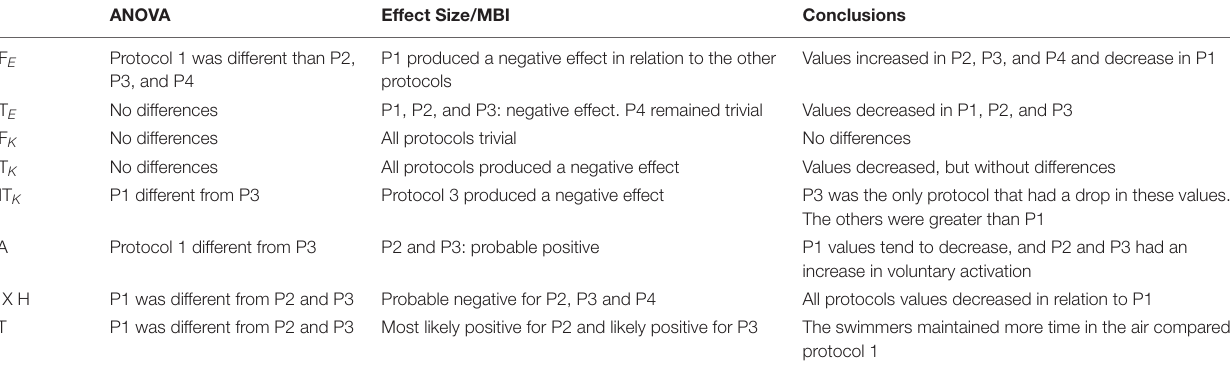
TABLE 1 | Comparison of statistical methods (ANOVA, Effect Size and Magnitude Based Inferences) used for analysis and conclusions of the main results.